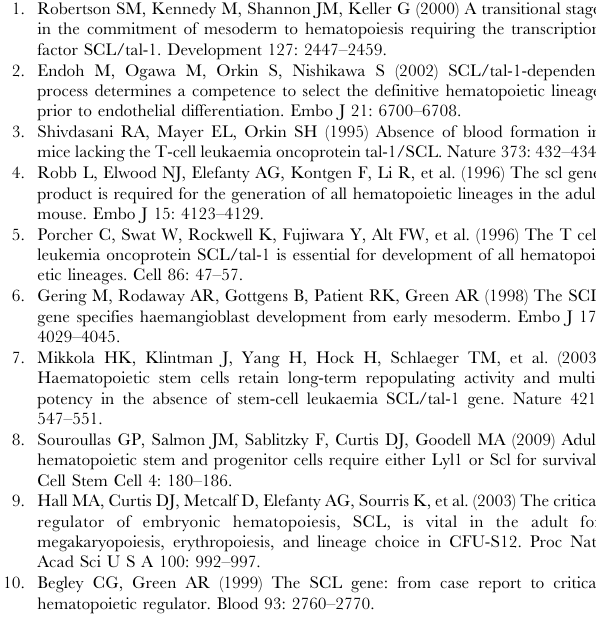
Table S6 Oligonucleotide primer pairs used to perform SyBr green quantitative real-time PCR for regions enriched for histone H3 K9/K14ac. Amplicon names in the first column are as shown in Figure S2 (panel a) while the second column lists alternative